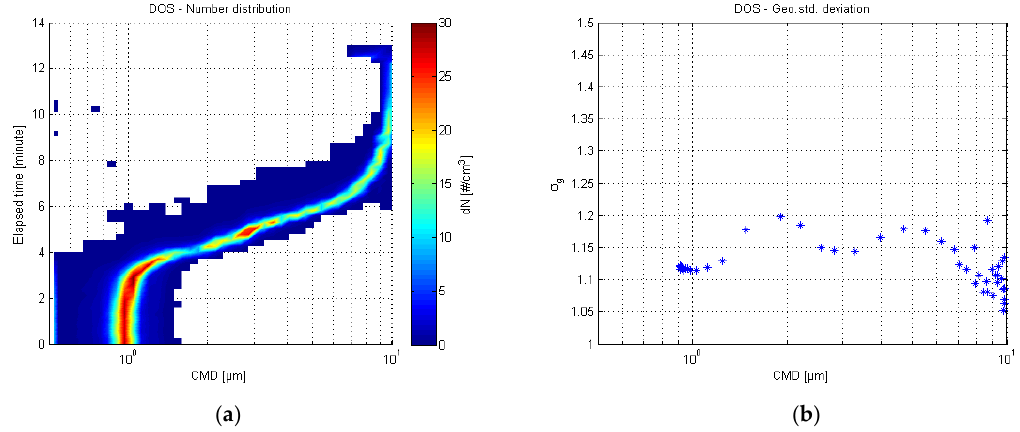
Figure 2. Aerodynamic Particle Sizer (APS) number distribution of the dioctyl sebacate (DOS) test ( a ) and the respective geometric standard deviation plot ( b ).